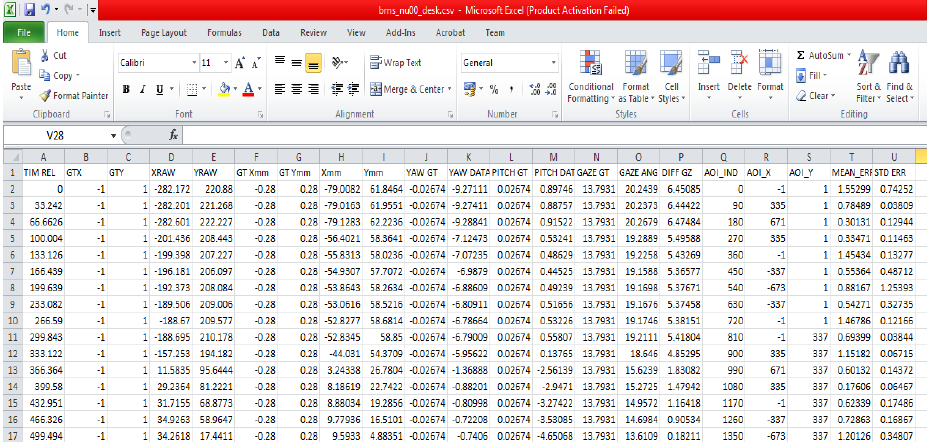
Figure 15. Dataset organization in the NUIG_EyeGaze01 repository on Mendeley data.